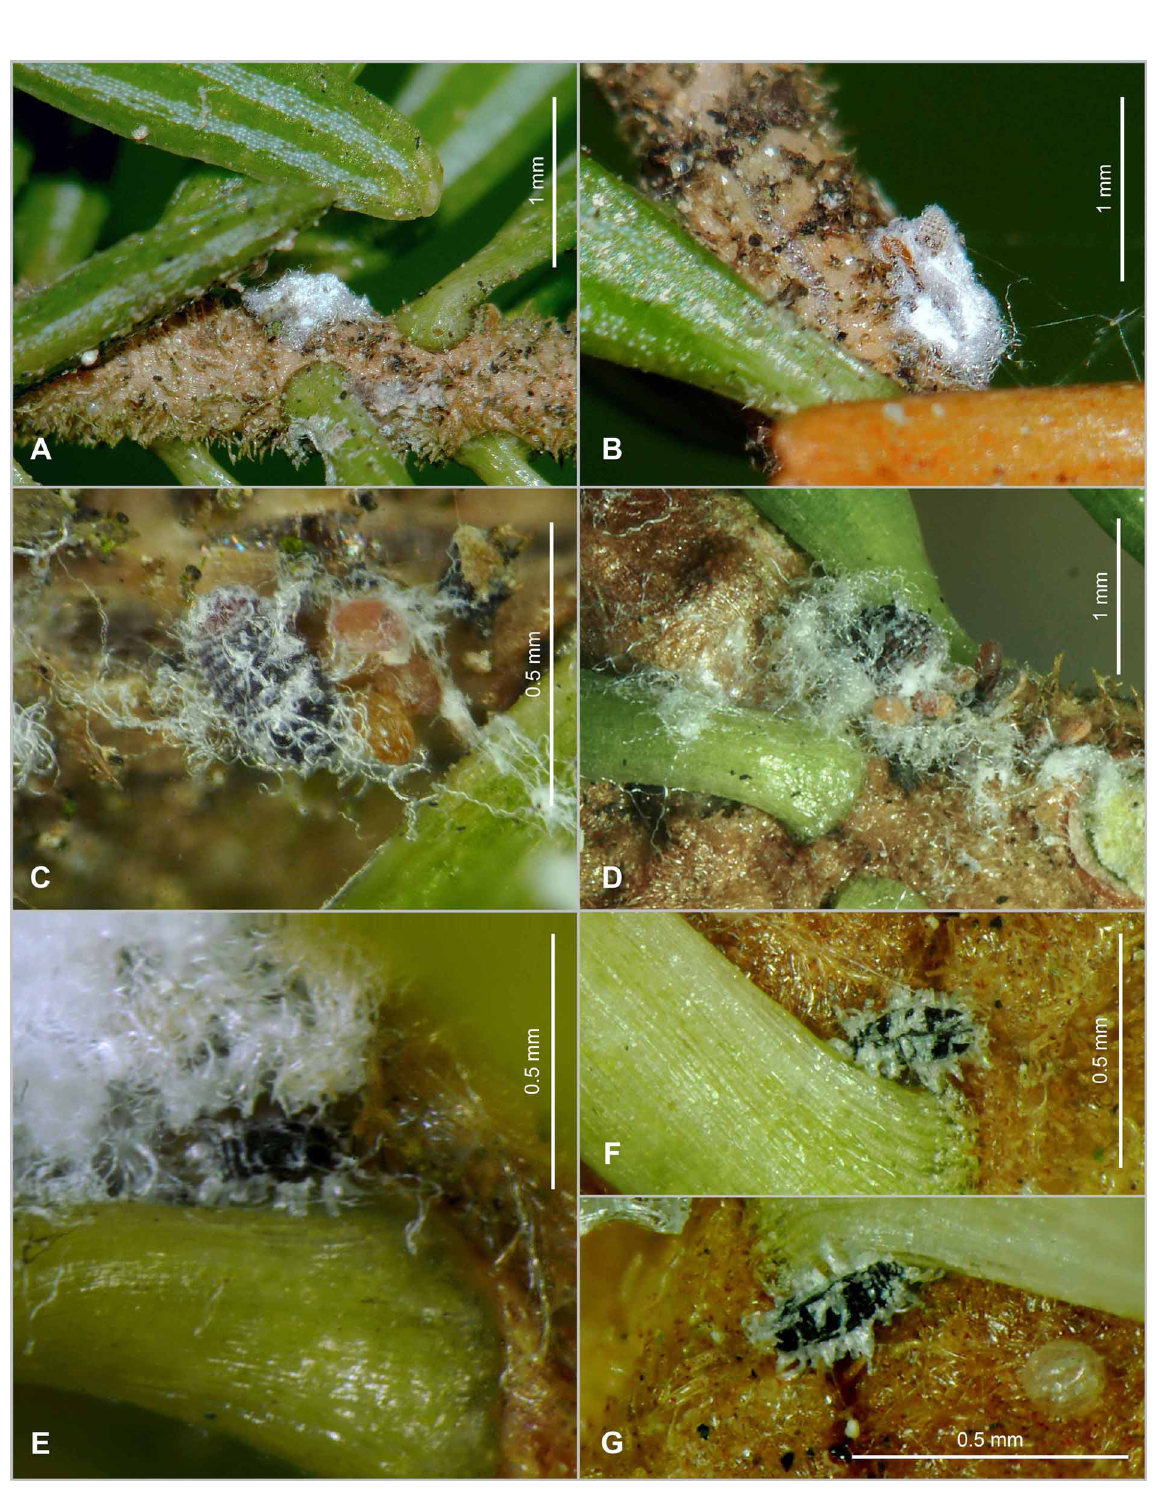
Fig. 45. Adelges (Dreyfusia) nordmannianae (Eckstein, 1890) on Abies alba . A–D . Apterous progredientes with eggs. Note the thin, woolly wax filaments. E–G . First instar hibernating nymphs